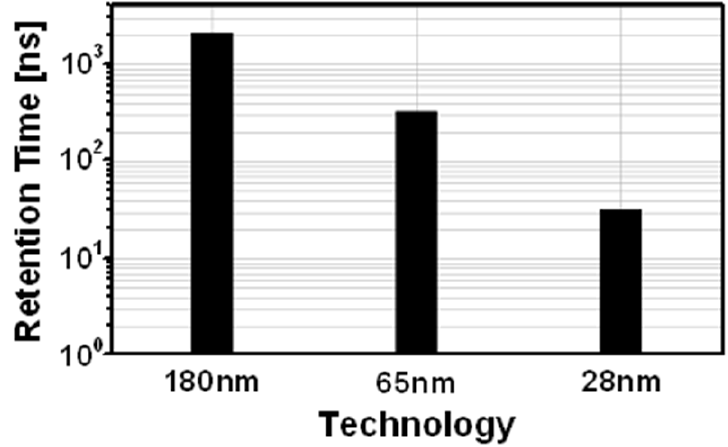
Figure 2. Retention time of 2T gain cell implemented in 28, 65 and 180 nm processes.